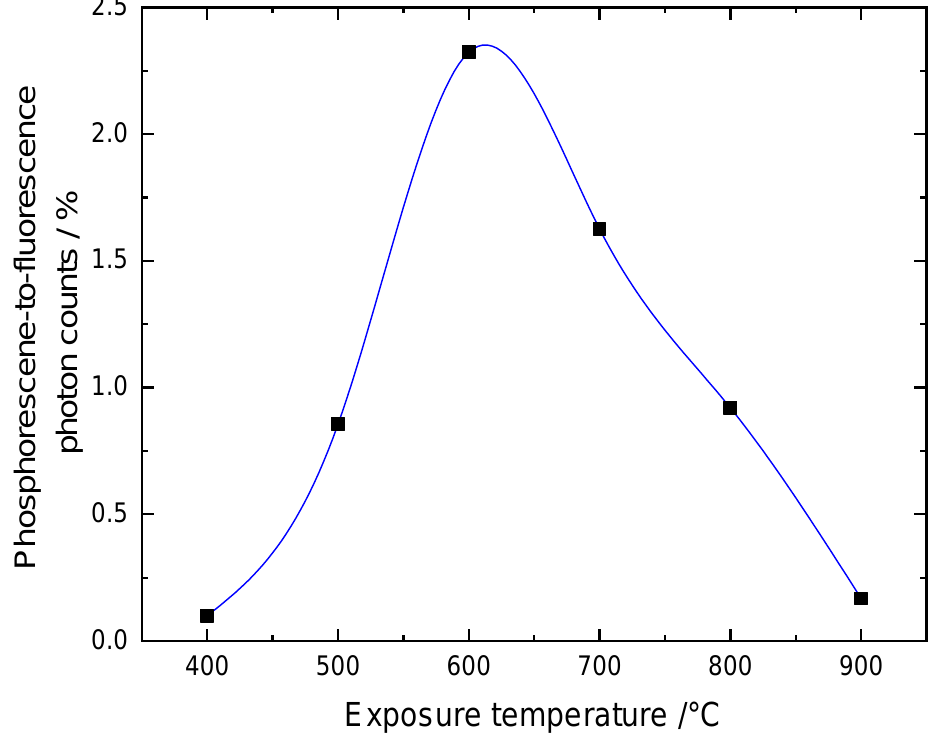
Figure 3. Ratio of phosphorescence to fluorescence intensities derived from Figure 2b. The line is a guide to the eye only.